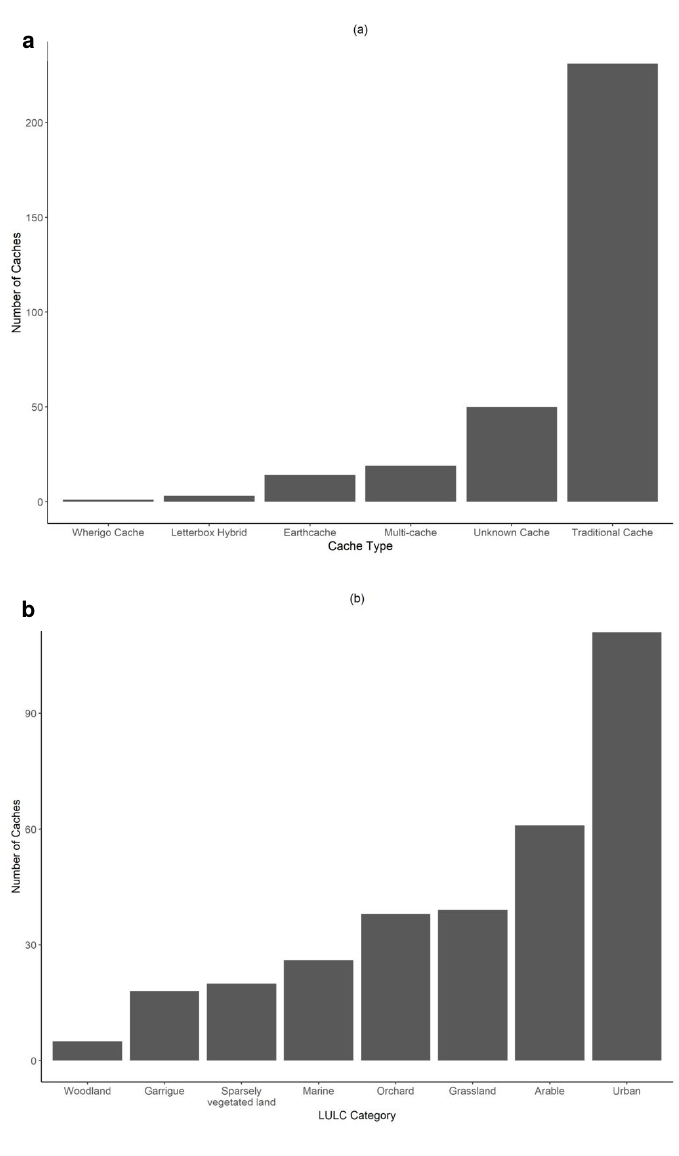
Figure 2. Number of geocaches according to the (a) cache type and (b) land use land cover (LULC) category. a : Number of geocaches according to the cache type. b : Number of geocaches according to the land use land cover (LULC)